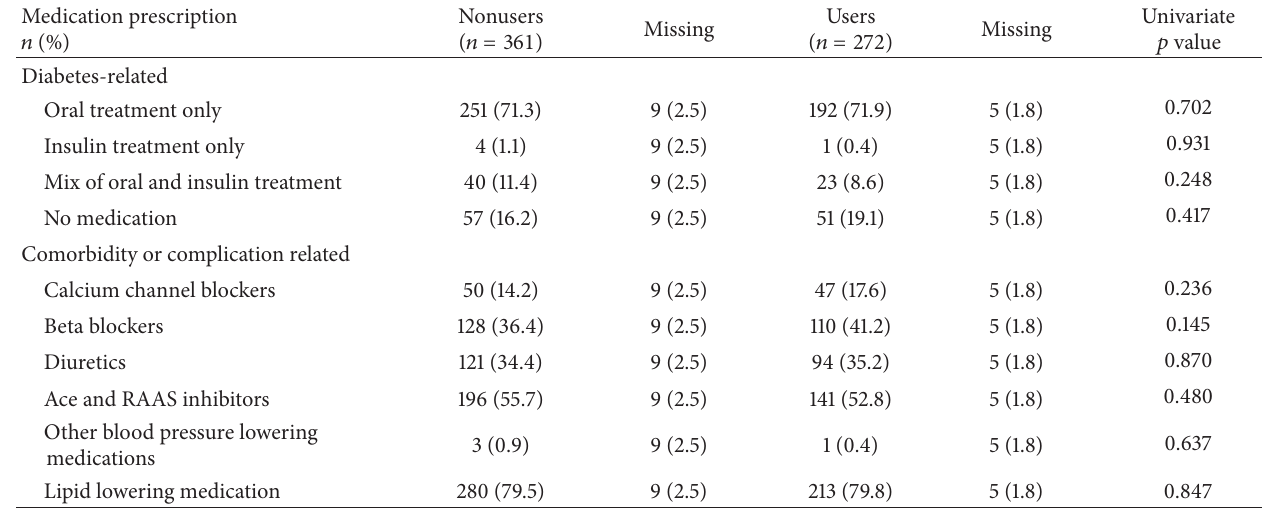
Table 5: Medication use of users and nonusers.